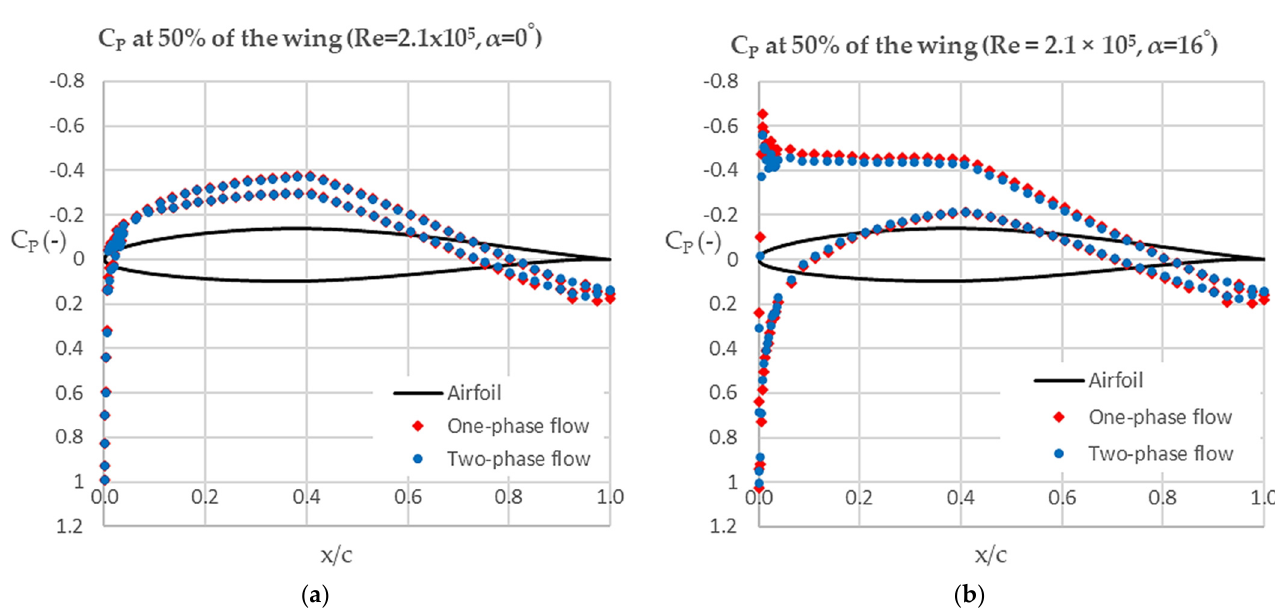
Figure 13. Coefficient of pressure distribution around airfoil at 50% of the original wingspan in one-phase flow and two-phase flow: ( a ) AoA = 0°; ( b ) AoA = 16°.